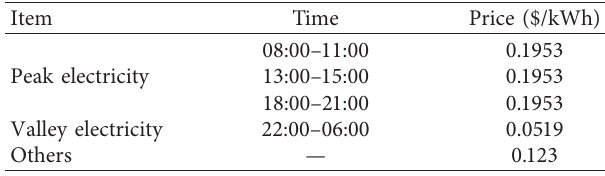
Table 3: Electricity priceforindustrialandcommercialcustomers[30].